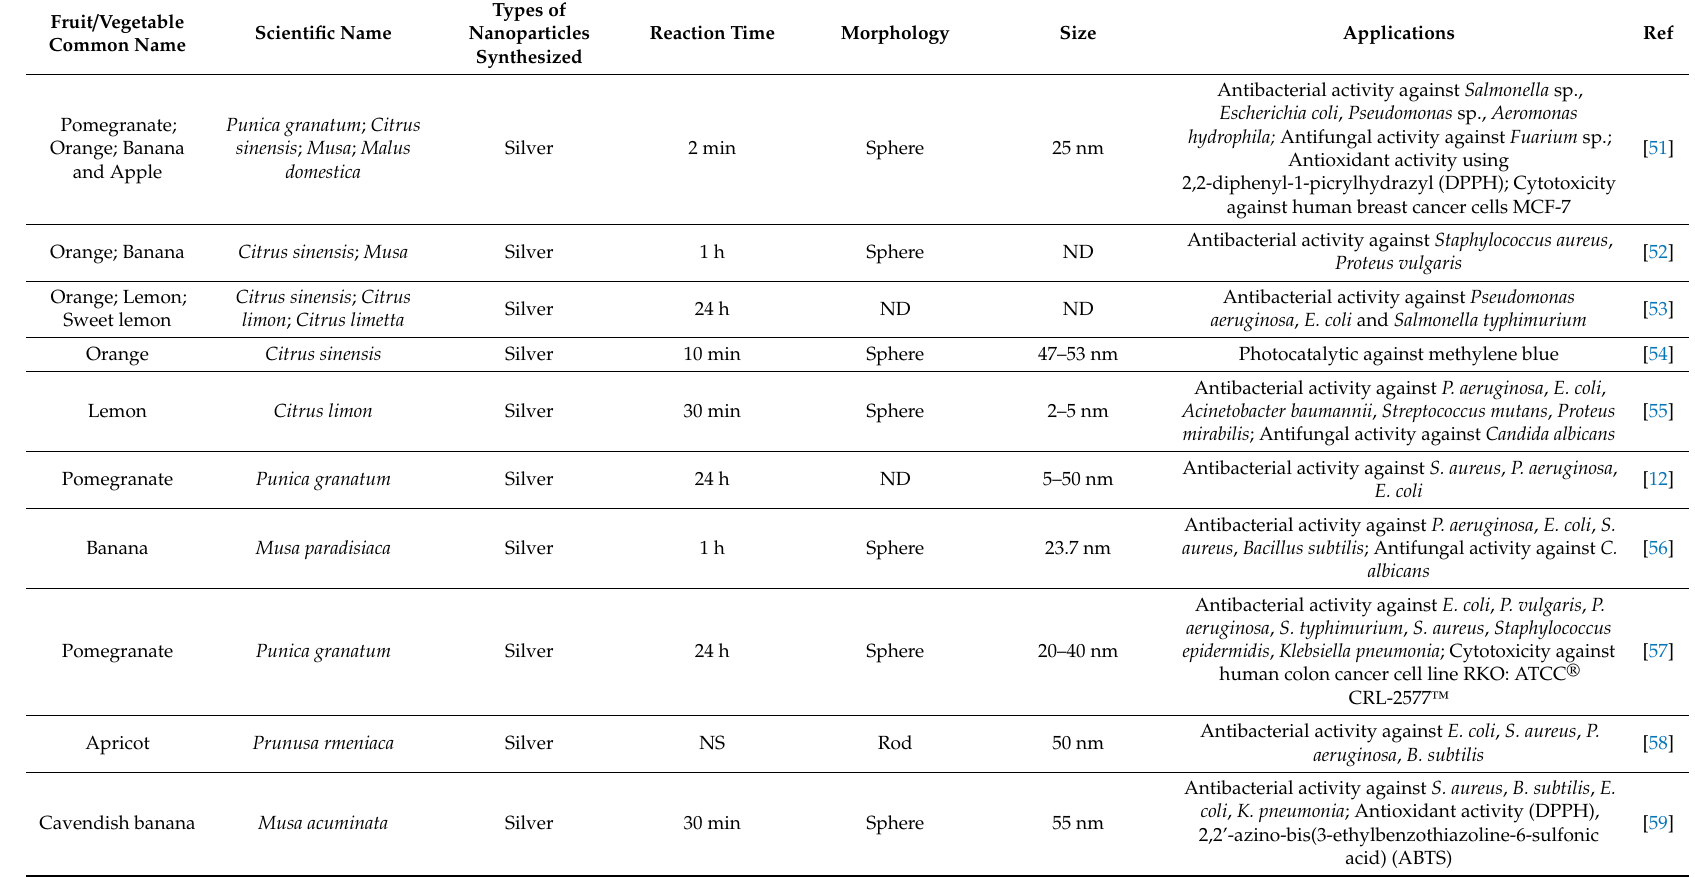
Table 2. Fruits and vegetables peel derived metallic nanoparticles with their